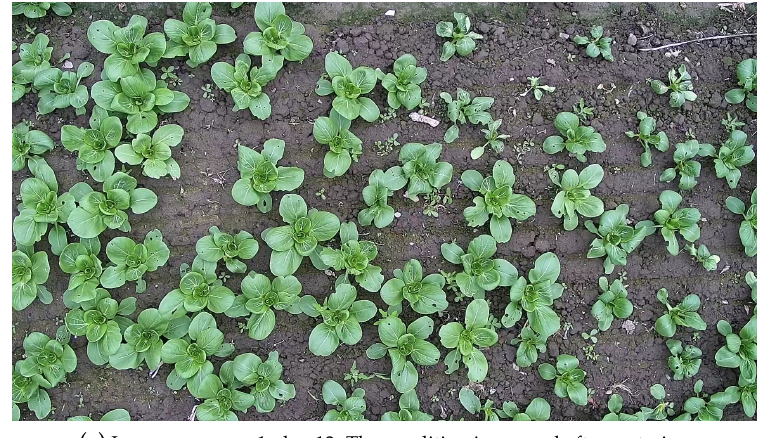
Figure 8. Images from day 11 to day 13 day in image sequence 1. As a result of the day light intensity caused water shortage, leafy green vegetables appear leaf shrinkage phenomenon, as shown in the change between Sub-figure ( a , b ). After watering, most of the plants returned to growth, as shown in Sub-figure ( c ).